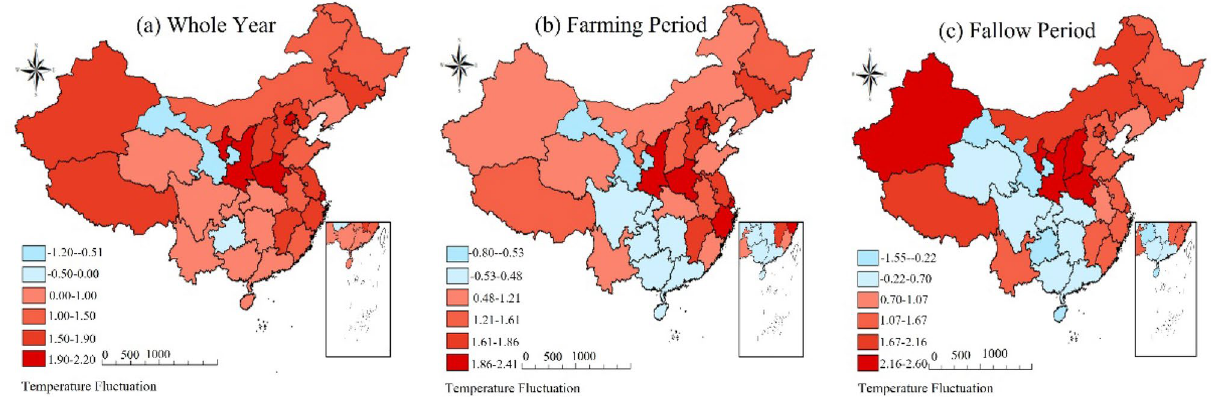
Figure 4. Distribution of low temperature fluctuations in main provincial cities in China (regional minimum temperature—regional historical average